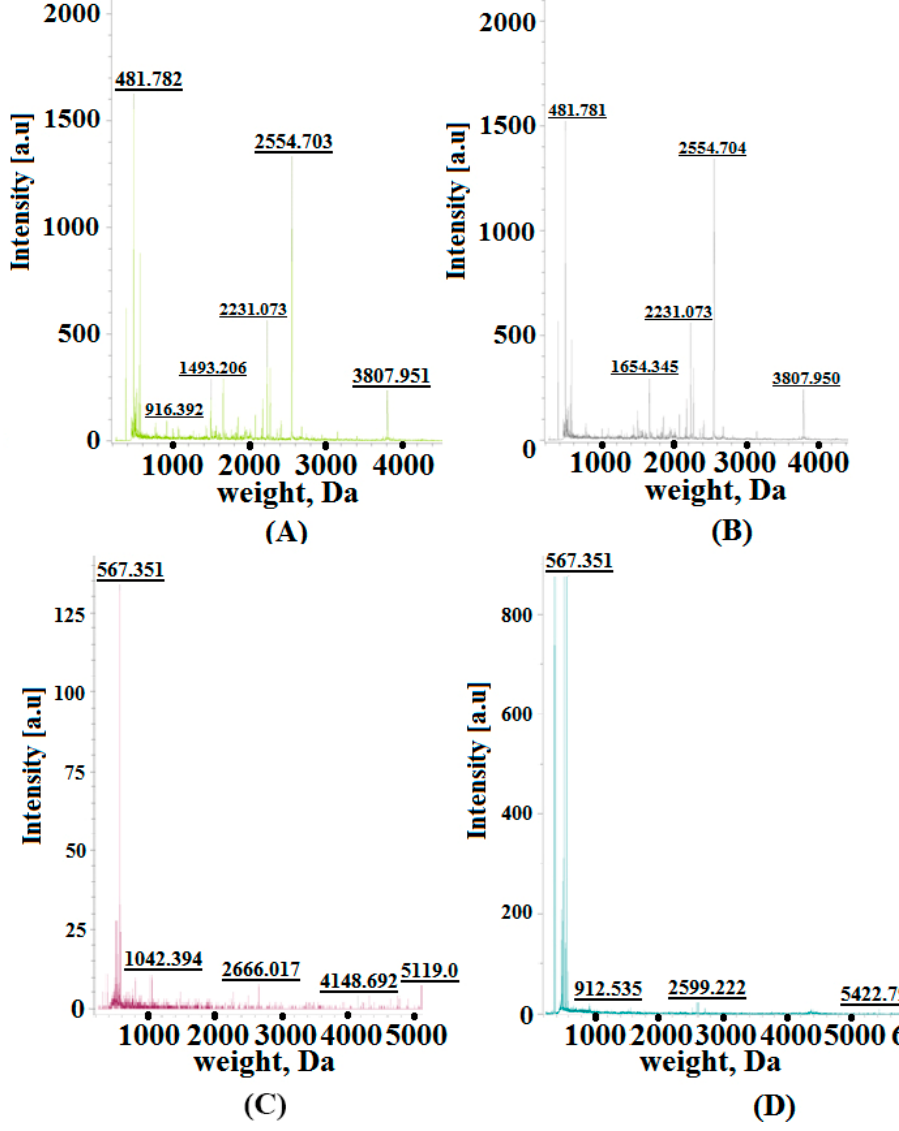
Figure 4. MALDI-TOF mass spectrogram of Dosidicus gigas collagen ( A , B ) and Bos taurus collagen ( C , D ) proteolytic digestion products by ( A , C ) collagenase and ( B , D ) trypsin. [a.u.]—absorption units